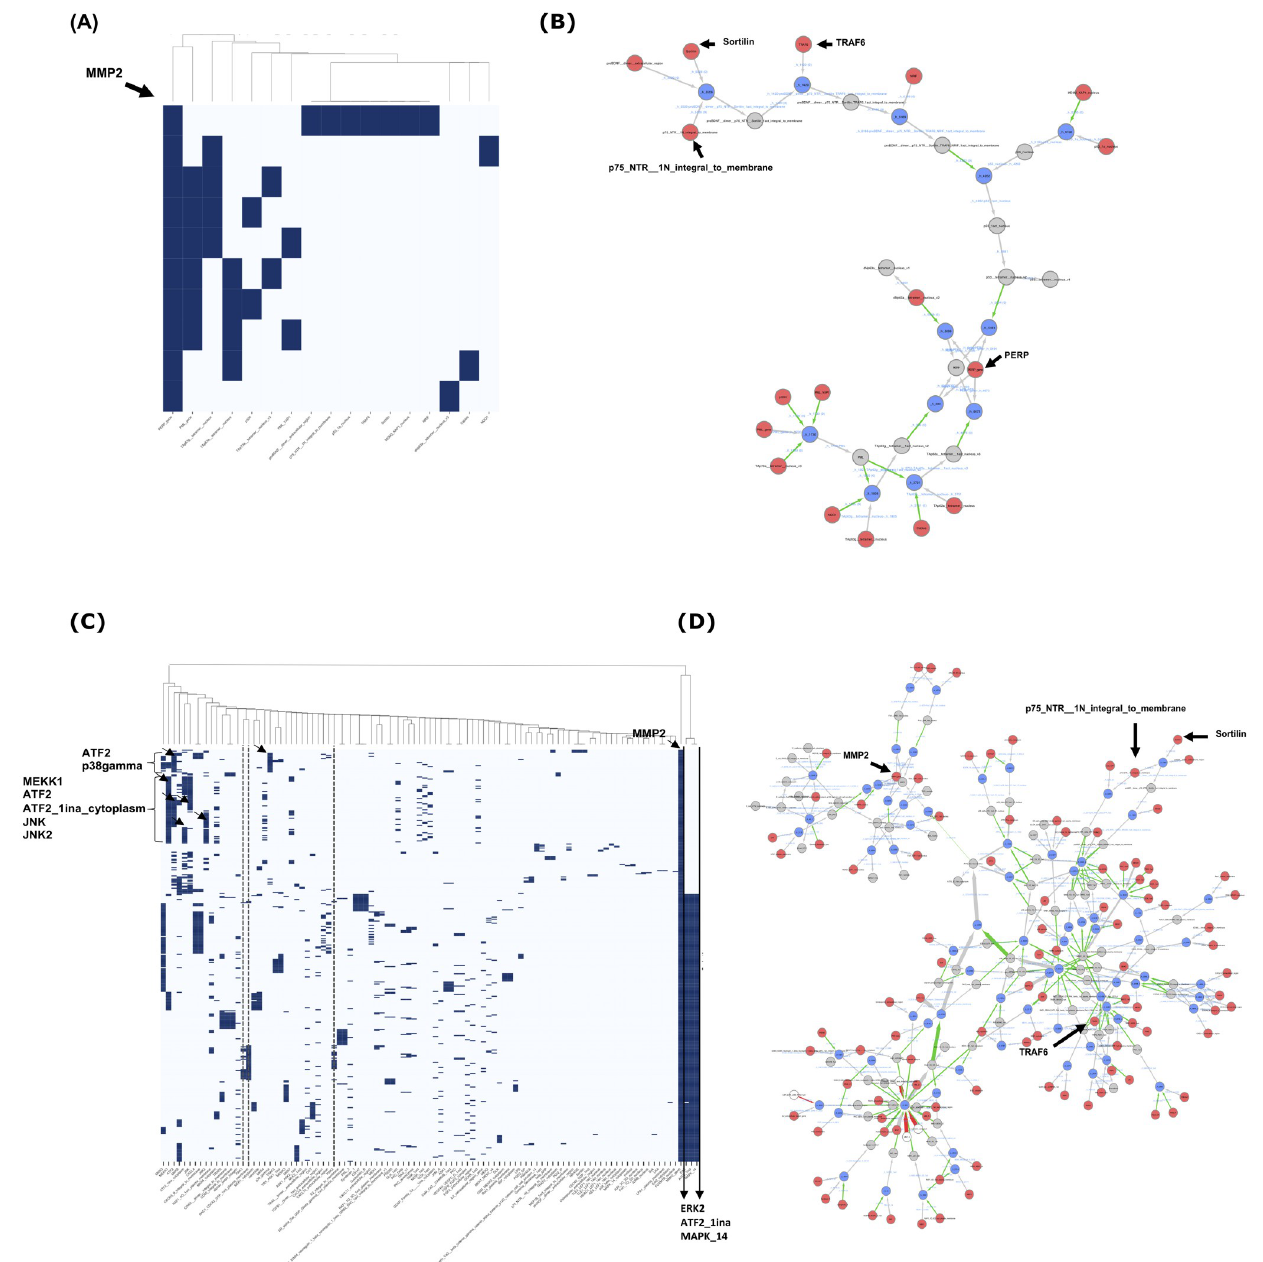
Fig 7. Analysis of trajectories obtained from PERP and MMP2 independent queries. (A) & (C) : Clustering analysis of trajectories based on controllers. PERP query (A) returns 10 trajectories including 17 controllers and MMP2 query (B) returns 400 trajectories including 101 controllers. (B) & (D) : Graphical representation of the trajectories resulting from PERP (B) and MMP2 (D) queries. Red nodes are the cadbiom model boundaries. Grey nodes are the basic entities/intermediate molecules that are not at the boundary model. The blue nodes are reaction nodes that are only displayed when there is more than one reagent or one reactant in a reaction (many-to-many or one-to-many relationship between reactants). The white nodes are the inhibitors, they are never in the solutions nor in the trajectories. Their presence is forbidden for the production/activation of the molecules of interest. The grey arrows are the reactions (unary reactions) (one-to-one relationship). The red arrows are inhibitions and the green arrows are activations (reaction controls).